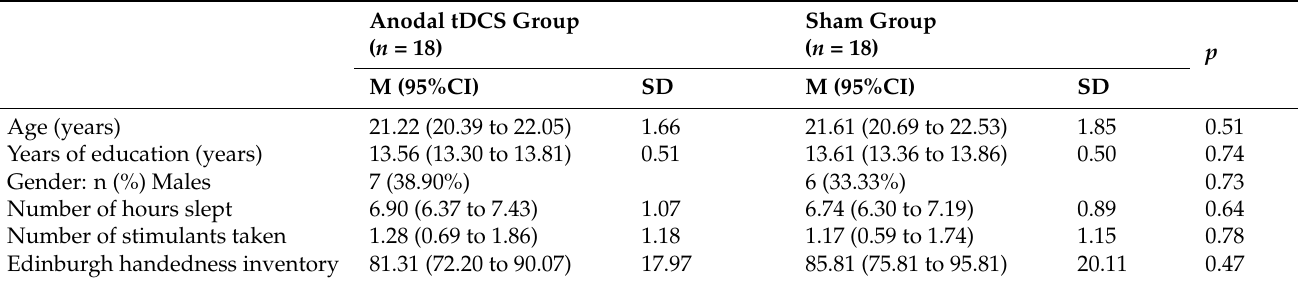
Table 1. Results of the basic information.